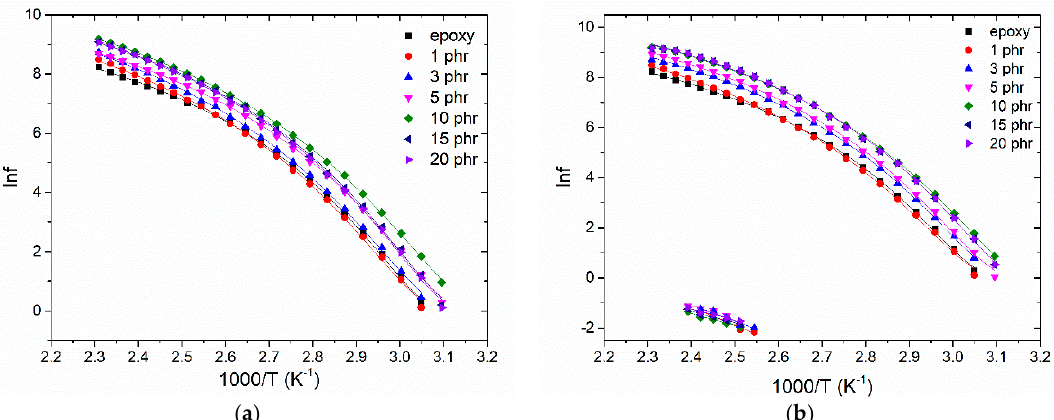
Figure 8. Temperature dependence of the loss peak position for the IP and α -relaxation mechanisms for the nanocomposites with: ( a ) BaFe 12 O 19 ; ( b ) SrFe 12 O 19 nanoparticles. Table 1. Specimens’ composition in phr, activation energy values and parameters derived via fitting data with Equations (2) and (3), for all studied systems and glass transition temperature as determined via